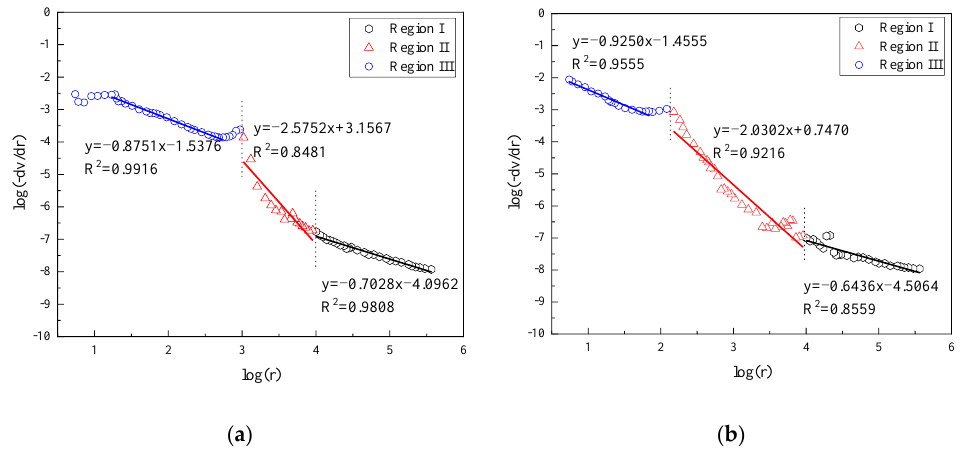
Figure 17. Multifractal characteristics of CCP10 at different ages under Pfeifer and Avnir’s model. ( a ) 3 days, ( b ) 28 days.